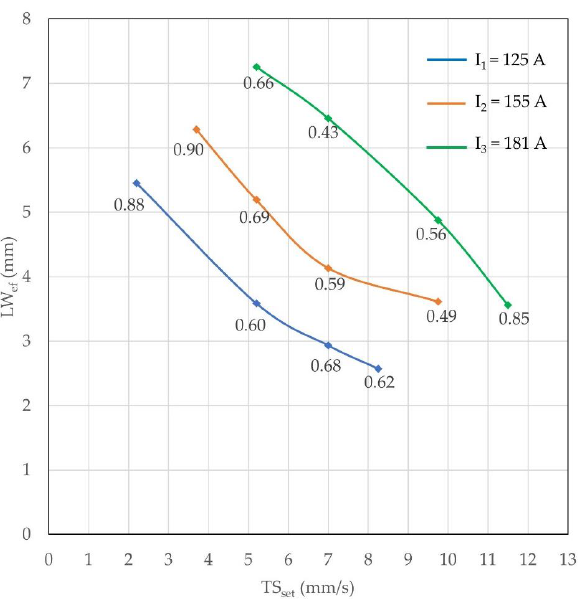
Figure 20. SW index corresponding to the 12 experiments, according to the design for the experiments (the lumped area inside the Im and TS workable limits represent the working envelope). J. Manuf. Mater. Process. 2020 , 4 , 14